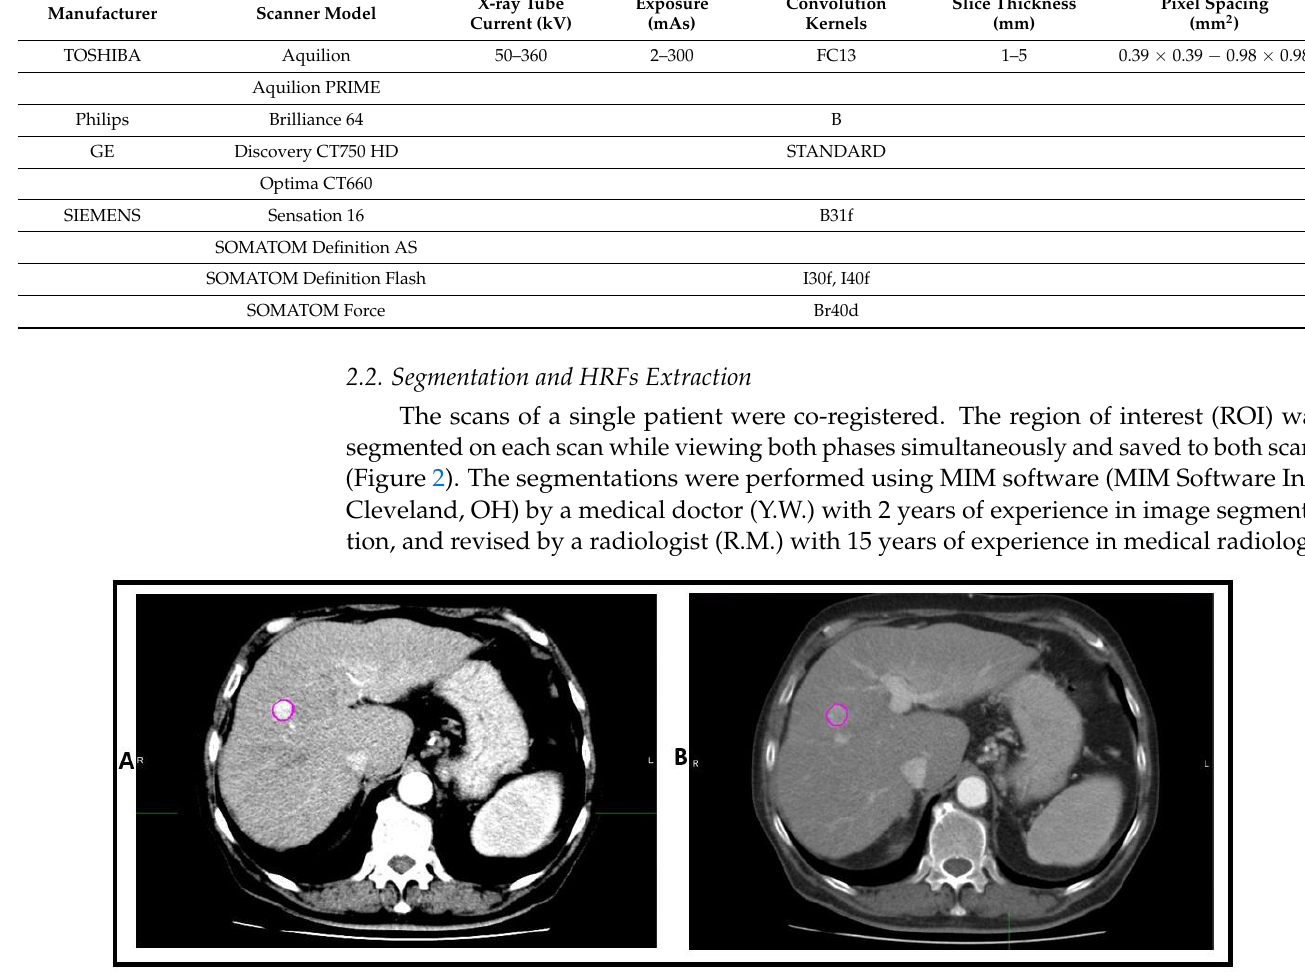
Table 1. Acquisition and reconstruction parameters for the imaging dataset.